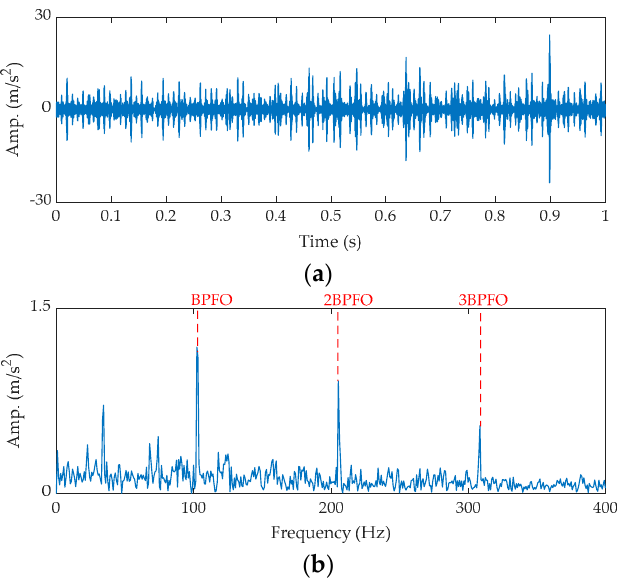
Figure 9. The results by ICFGF for the outer fault signal: ( a ) filtered signal and ( b ) SES. Both MMA and MA are re-run three times to show the superiority of MMA. Their average results are shown in Figure 10. From it, we can say the MMA has a faster con- vergence.